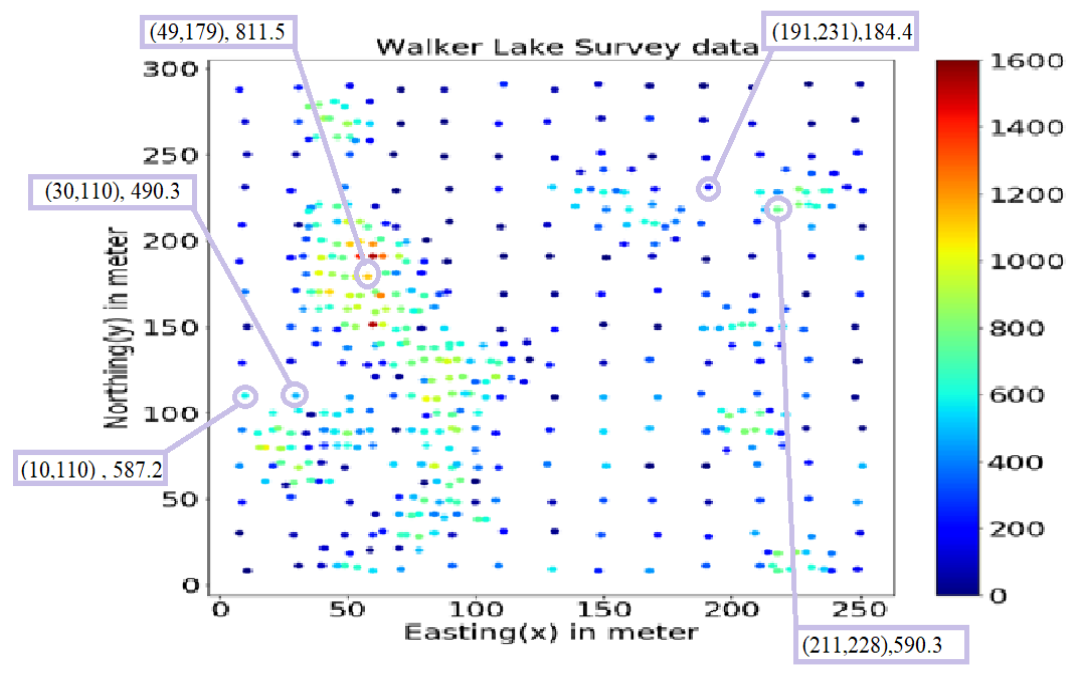
Figure 13. Spatial location of top 5 Features positively influencing the estimation in Walkerlake dataset.